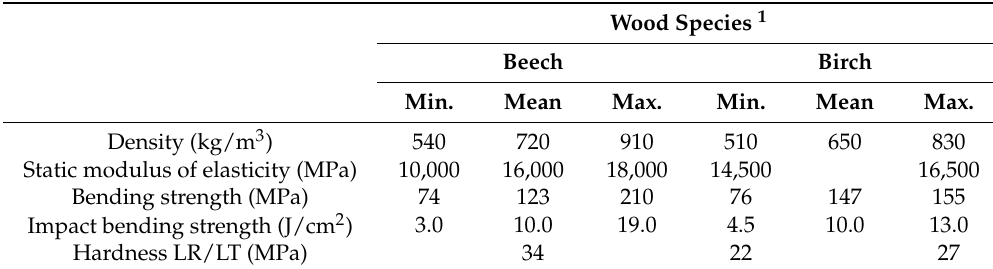
Table 2. Properties of Beech and Birch